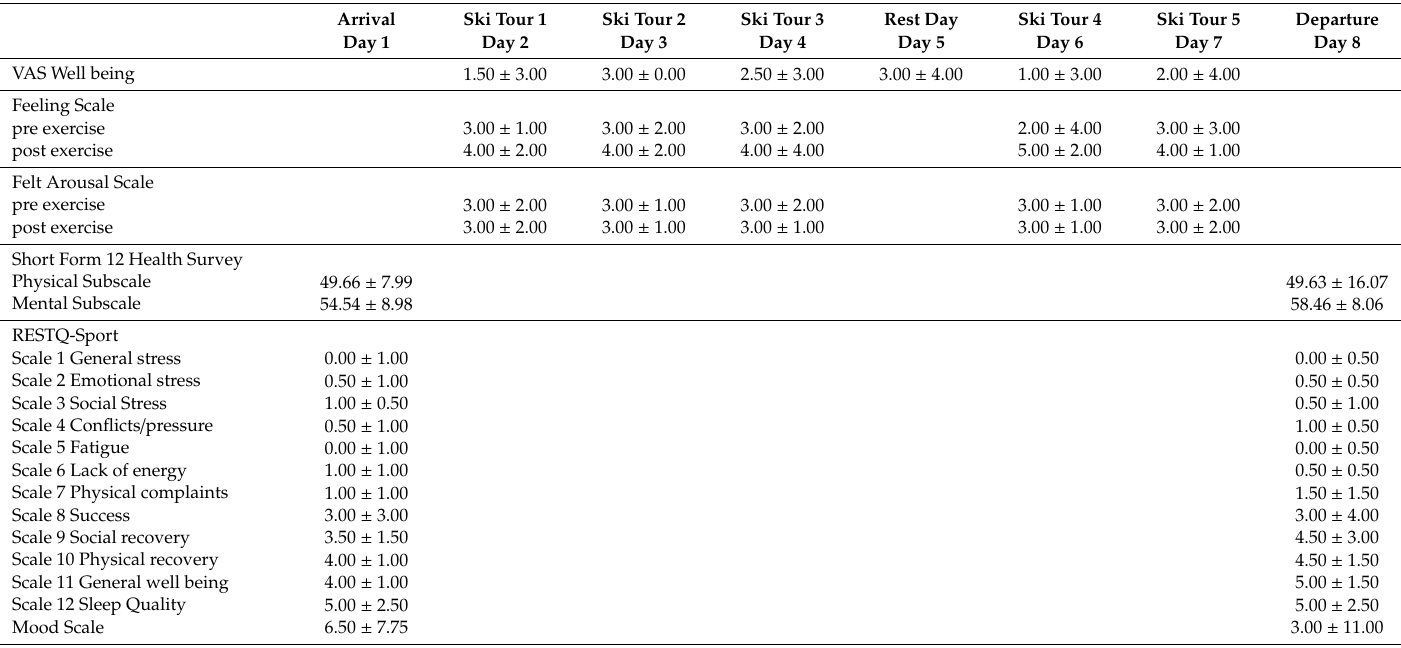
Table A3. Descriptive data of mental